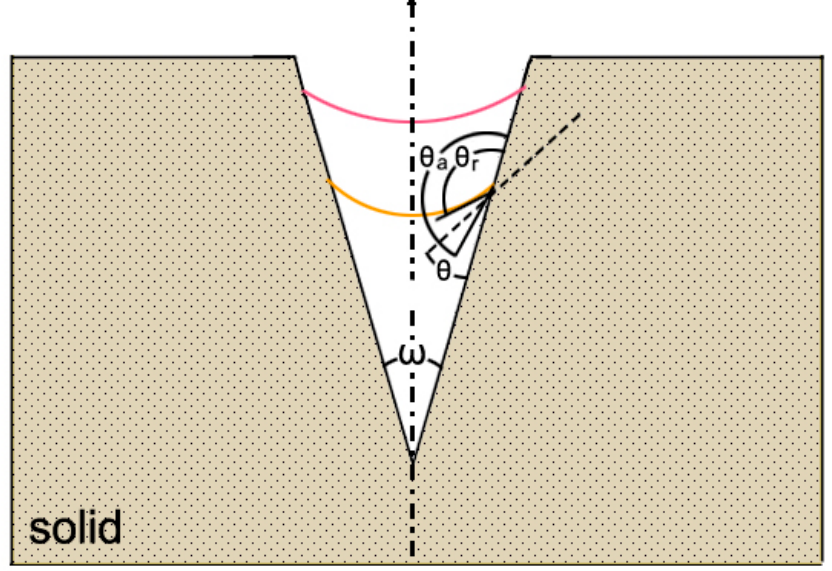
Figure 4. A bubble impended in a cone crevice of a very small apical angle, ω , and θ , the equilibrium contact angle, with θ a as the advancing angle and θ r the receding angle. Notice that the meniscus is now concave.